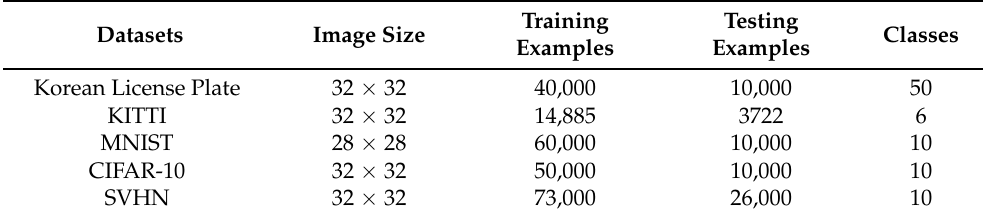
Table 2. Details of License Plate, KITTI, MNIST, SVHN and CIFAR-10 Dataset.